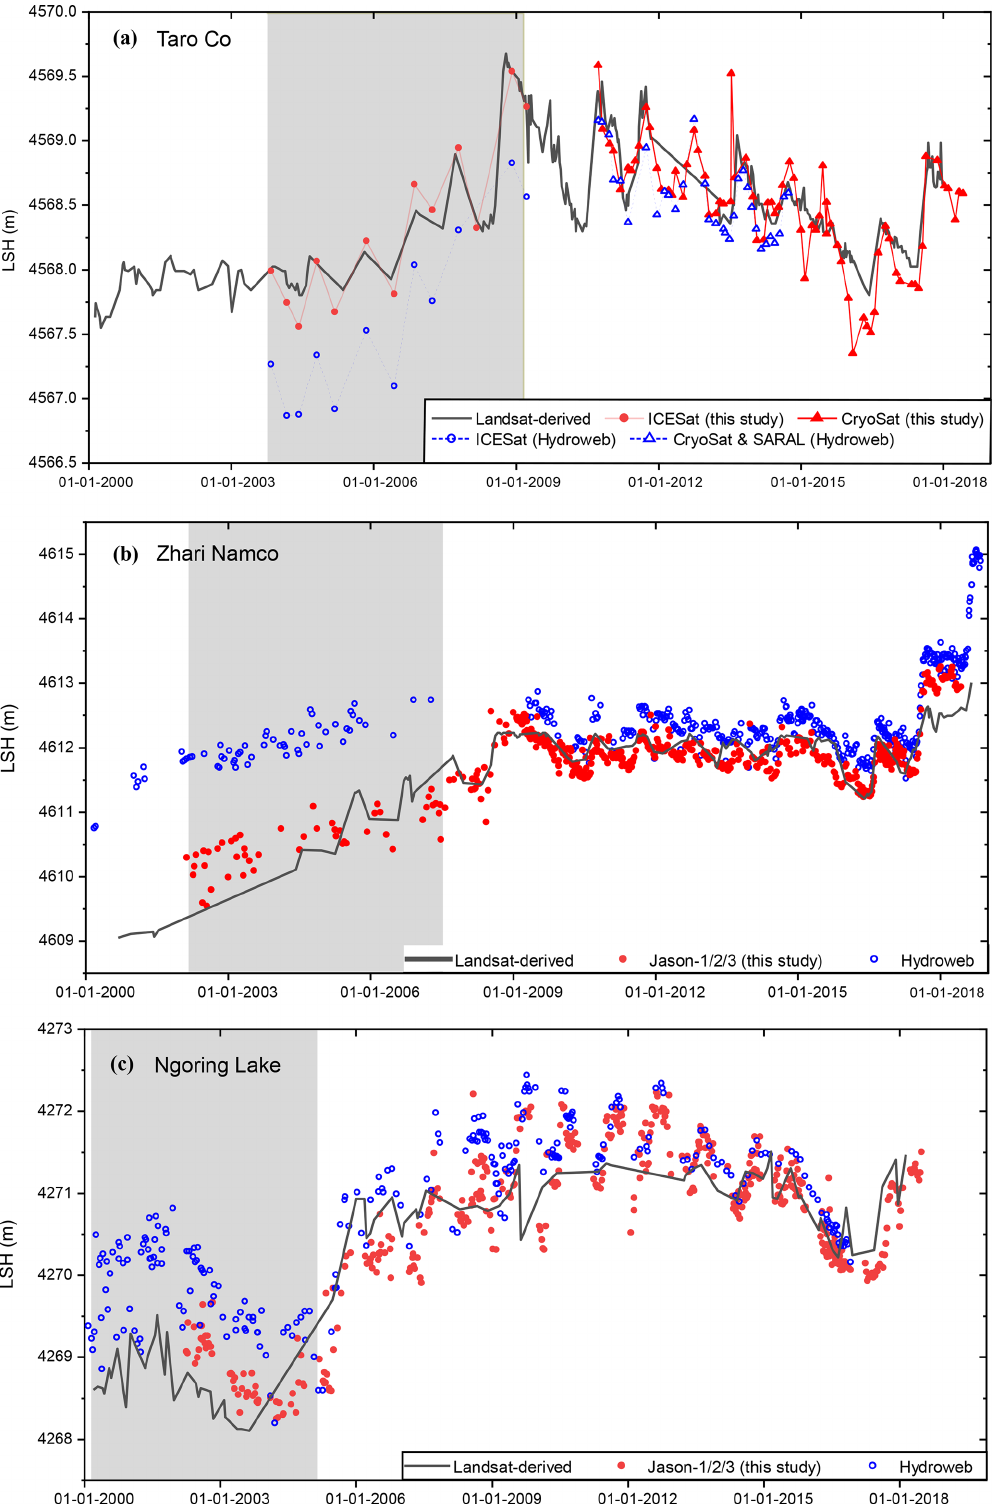
Figure 15. Similarities and differences between water level time series from the LEGOS Hydroweb database (Crétaux et al., 2011a) and our study. (a) Taro Co (31.14 ◦ N, 84.12 ◦ E). (b) Zhari Namco (30.93 ◦ N, 85.61 ◦ E). (c) Ngoring Lake (34.90 ◦ N, 97.70 ◦ E). Shading areas highlight the differences between the two data sets. LSH represents lake surface